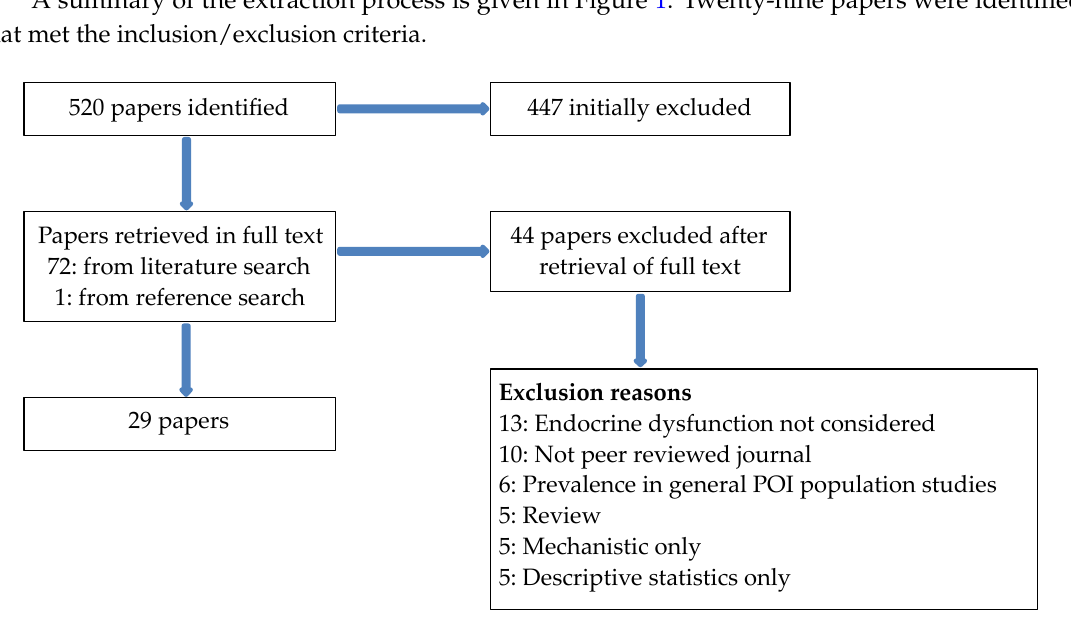
Figure 1. Summary of extraction process. POI: premature ovarian